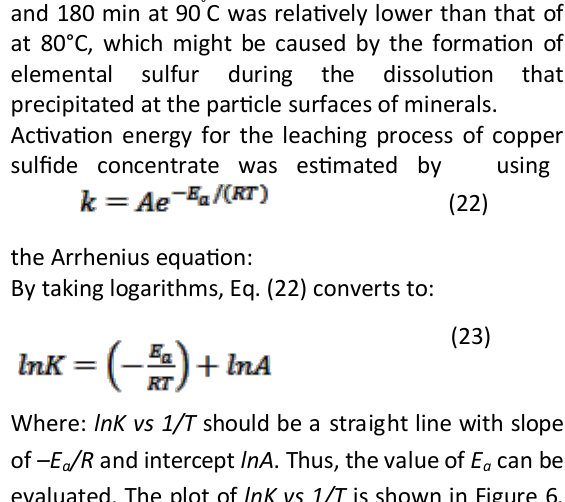
Fig. 8. X-ray diffractograms of leaching